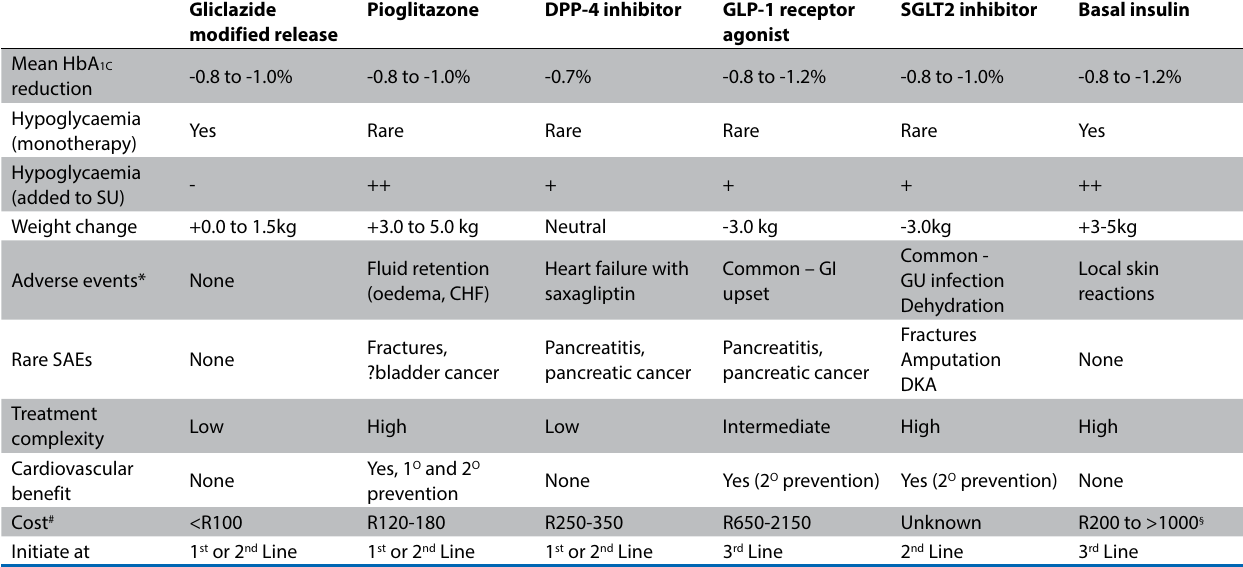
Figure I: Some of the factors to consider when choosing glucose lowering drug therapy at various stages of type 2